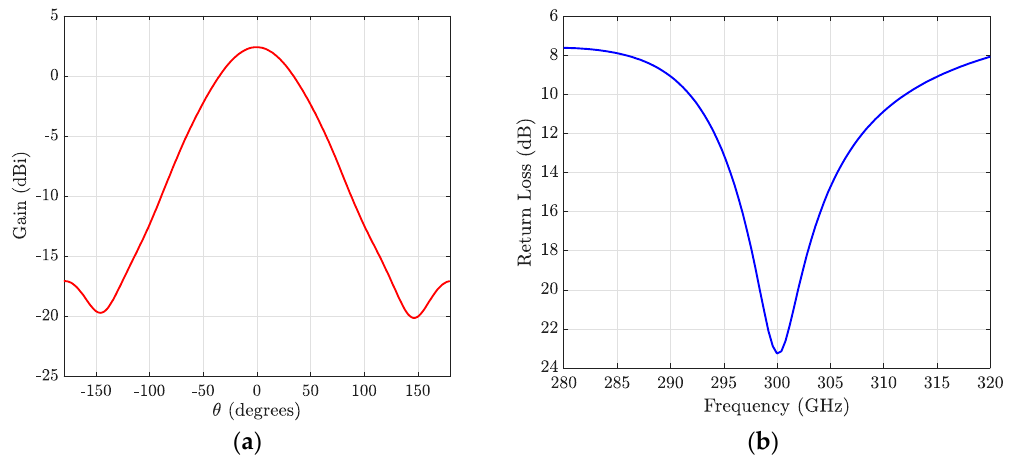
Figure 3. ( a ) Gain of unit cell, ( b ) return loss of unit cell.